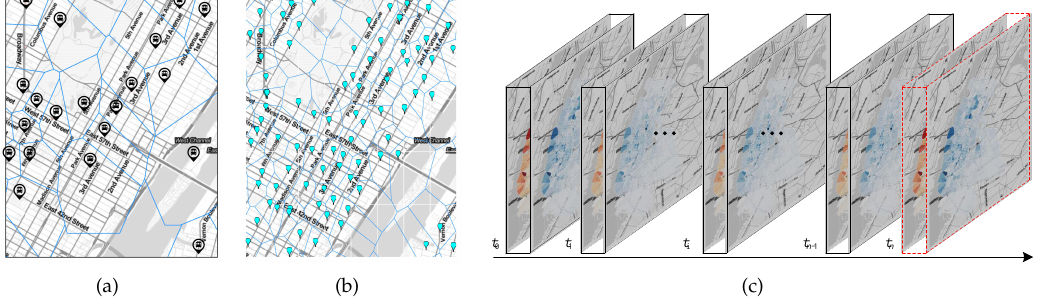
Figure 1. ( a , b ) Metro stations and bike-sharing stations in New York City; each station serves a region of the city, which could be roughly calculated by Voronoi-based segmentation; ( c ) the in–out crowd flow at each station aggregated along time axis can be viewed as a series of double-channel heat